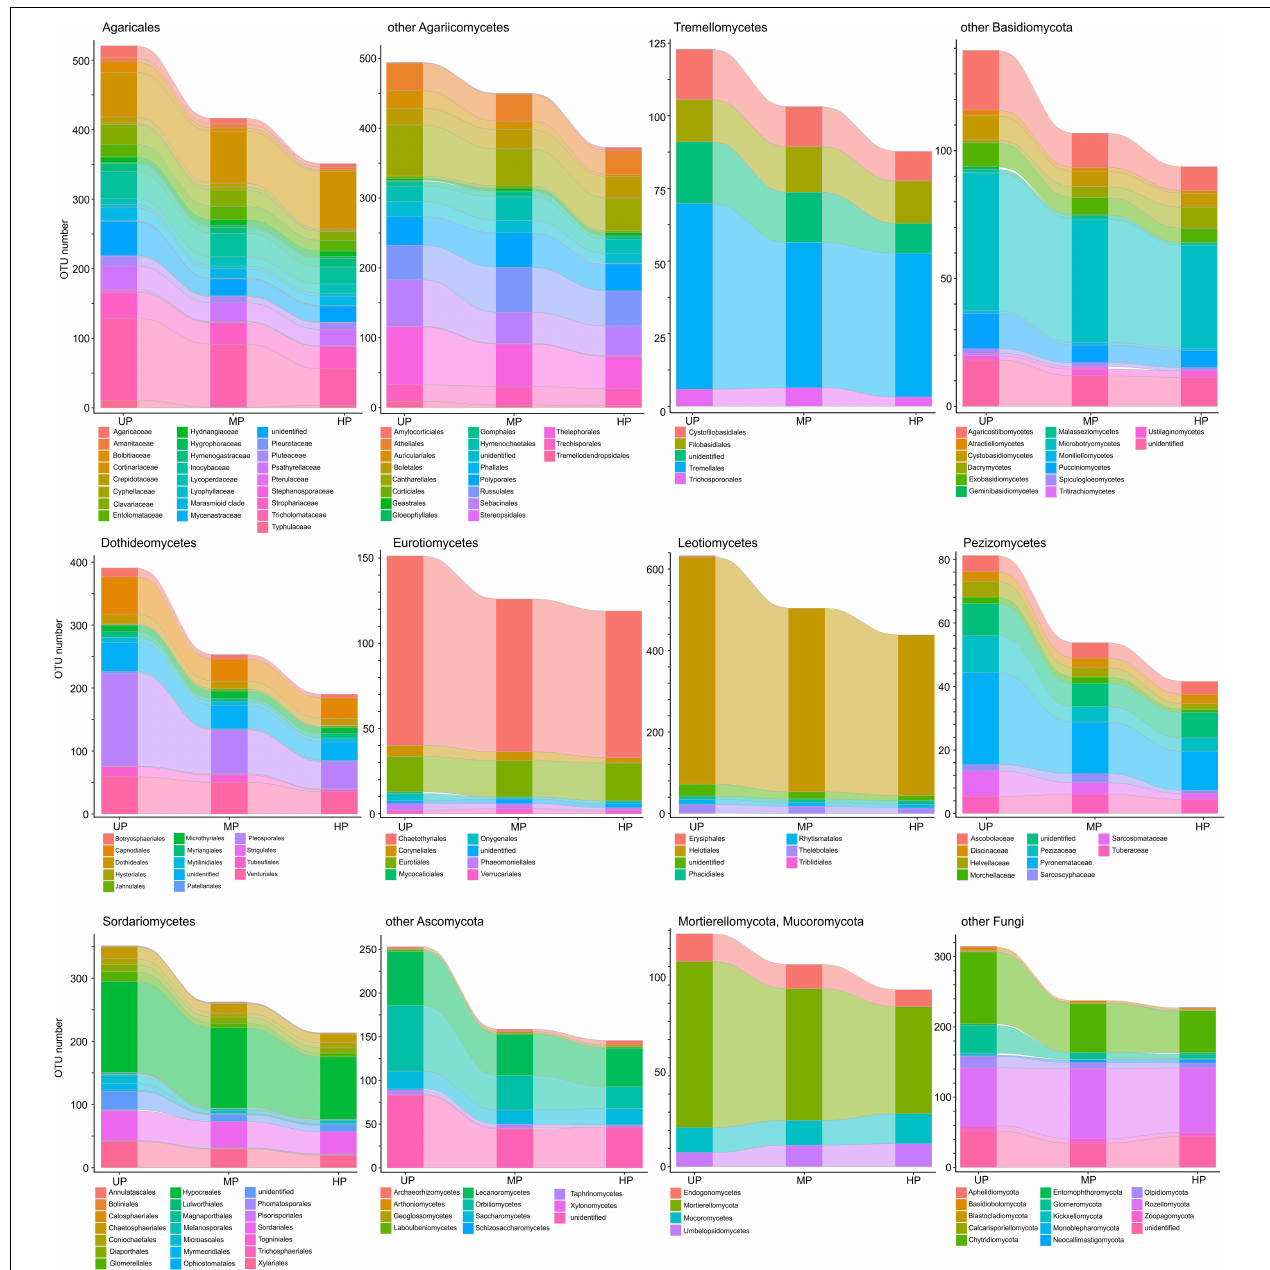
FIGURE 4 | Total OTU number of fungal taxa in the litter collected far from CWD in unpolluted (UP), moderately polluted (MP), and heavily polluted (HP) areas ( n = 29 samples per area). OTU, operational taxonomic unit; CWD, coarse woody